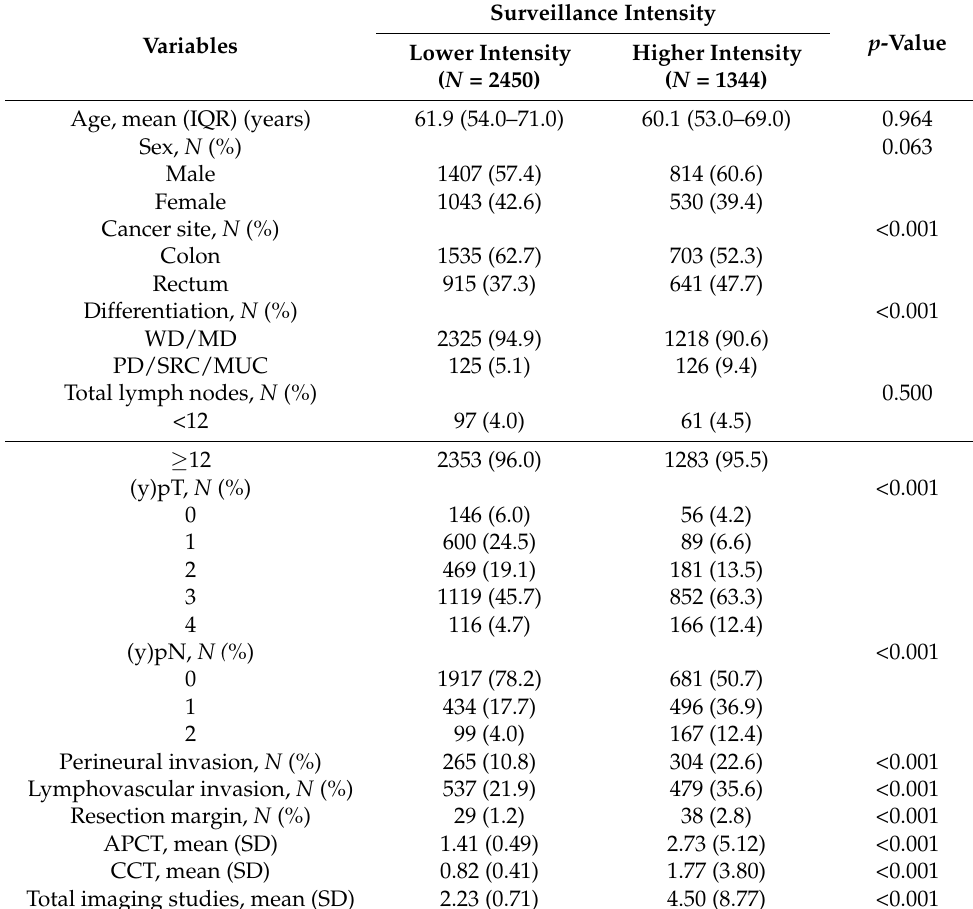
Table 1. Demographic and clinical characteristics of participants ( N =